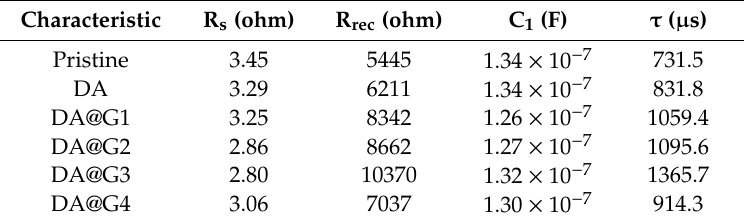
Figure 9. Nyquist plots obtained from the electrochemical impedance spectra: the scatters were the experiment data and the solid lines were the fitted. Table 2. Impedance characteristics of the tested devices.